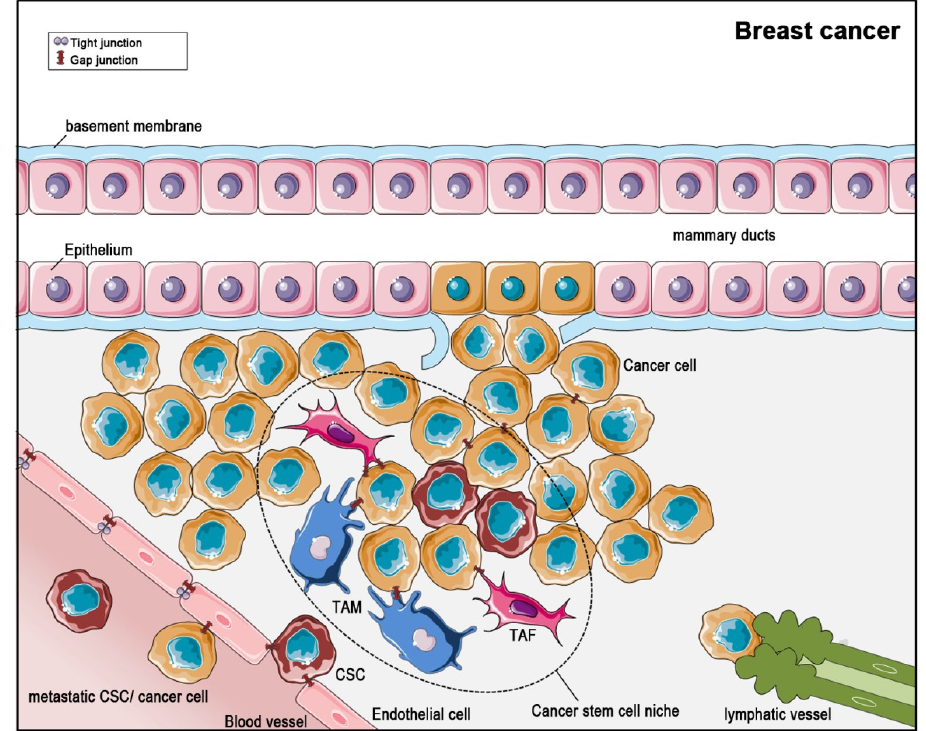
Figure 4. Formation and dispersion of breast cancer with regard to the cancer stem cell niche. Most breast cancers originate from abnormal epithelial cells of the mammary ducts. During tumor progression, the cancer cells break through the epithelial basement membrane. Cancer stem cells (CSCs) settle in a niche of tumor-associated macrophages (TAMs), tumor-associated fibroblasts (TAFs). Gap junction coupling for intercellular communication persist in-between cancer cells, and between the CSC niche cells and cancer cells. In breast cancer, two ways for metastasis exist: In the hematogenic path, cancer cells or CSCs enter the blood circulatory system, initiated by gap junction-mediated communication with endothelial cells. The endothelial cells themselves are sealed by tight junctions and communicate through gap junctions. In the lymphogenic path, CSCs or cancer cells enter lymphatic vessels at their open beginnings.